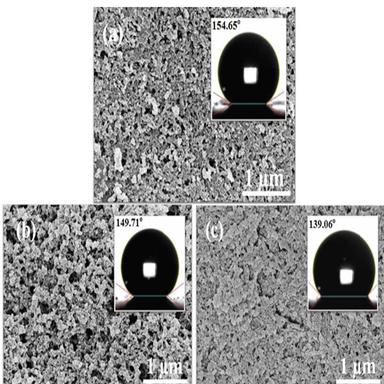
FESEM and the corresponding contact angle images of the PMSQ aerogels with E/M molar ratios of (a) 0, (b) 1 and (c) 2. Reprinted with permission from Ref..